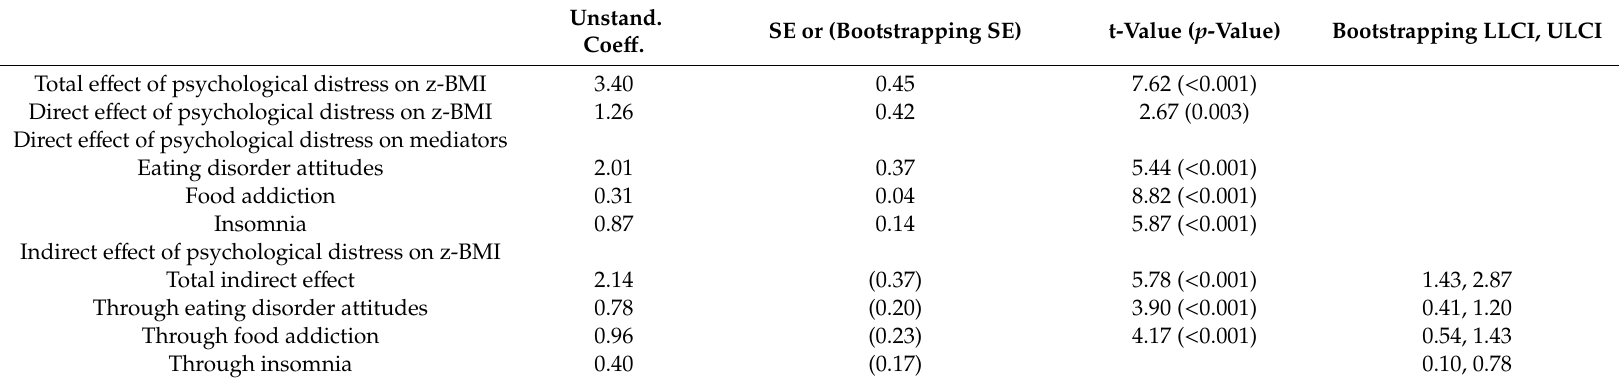
Table 3. Models of the e ff ect of adolescents (cid:48) psychological distress on body mass index (BMI) with mediators of insomnia, food addiction, and eating disorder attitudes. Unstand. SE or (Bootstrapping SE) t-Value ( p -Value) Bootstrapping LLCI, ULCI Coe ff . Total e ff ect of psychological distress on